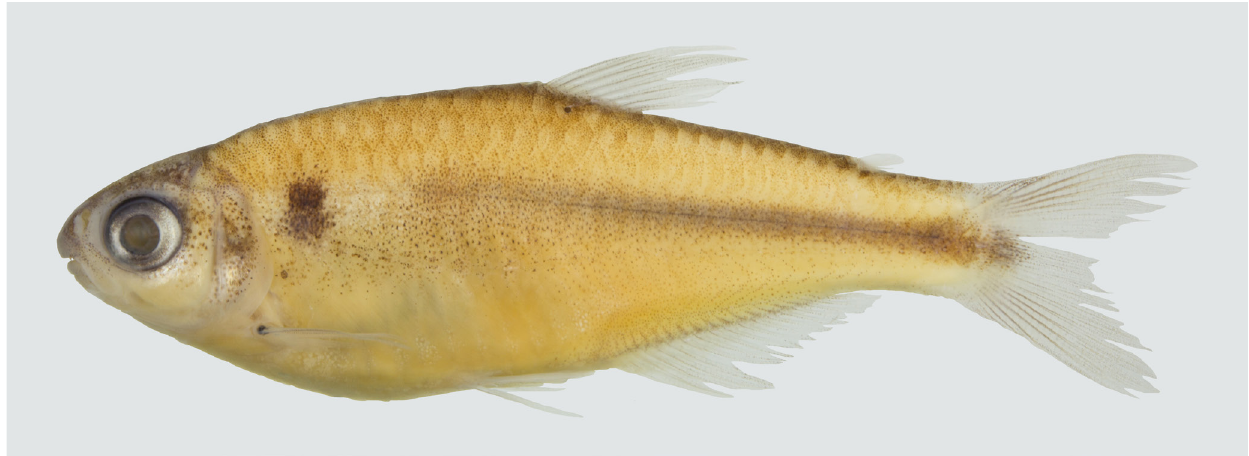
FIGURE 2 | Knodus rufford , holotype, NUP 22661, 35.4 mm SL, ribeirão Dois Irmãos, tributary to the rio do Peixe, tributary to the rio das Almas, tributary to the rio Maranhão, tributary to the rio Tocantins, Municipality of Pirenópolis, Goiás State,